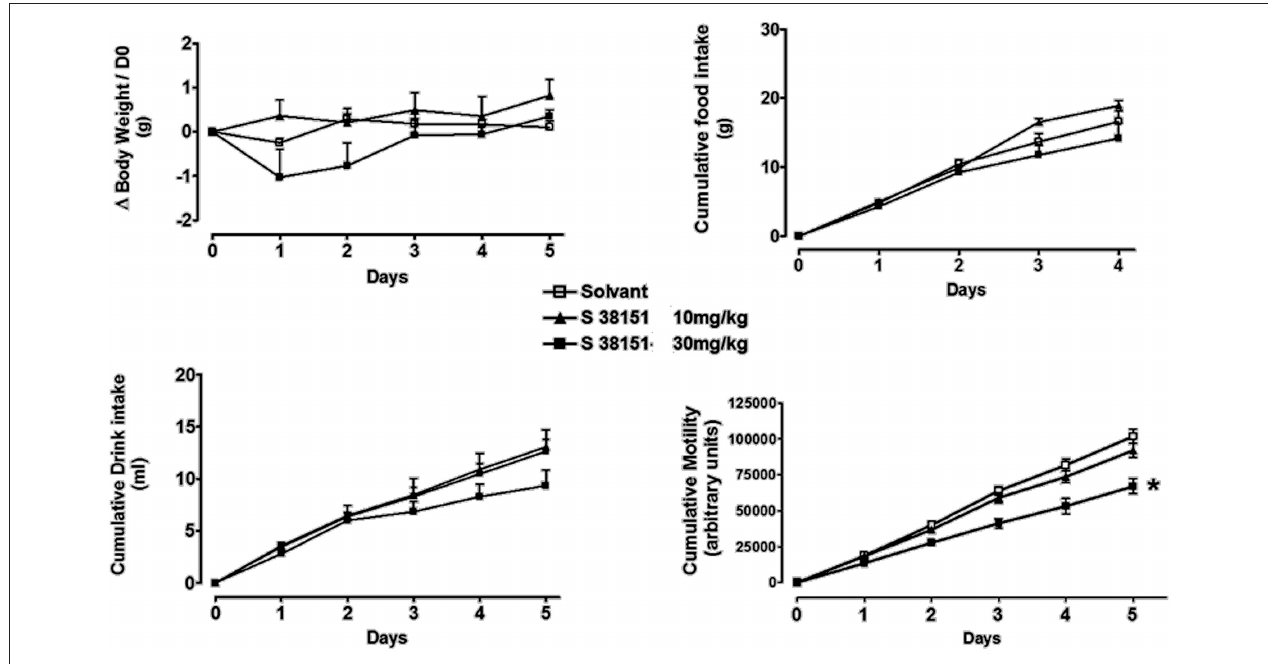
FIGURE 10 | The effects of repeated daily S38151 injection on food and water intake, body weight, and motility in MCHR1-KO mice. MCH 1 -KO mice were administered S38151 (10 and 30mg/kg, i.p.) or vehicle (normal saline i.p.) for 5 consecutive days. Results are expressed